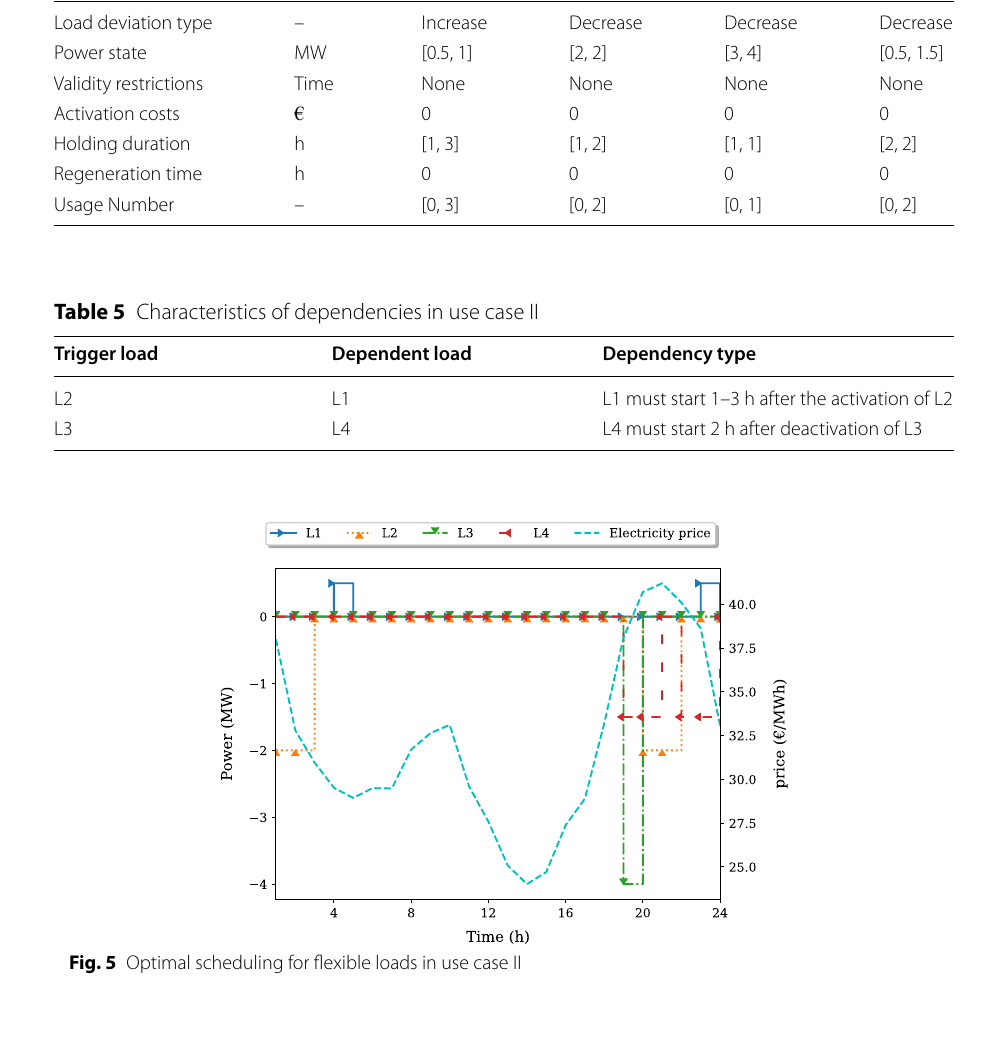
Table 4 Load’s characteristics considered in use case II key figure